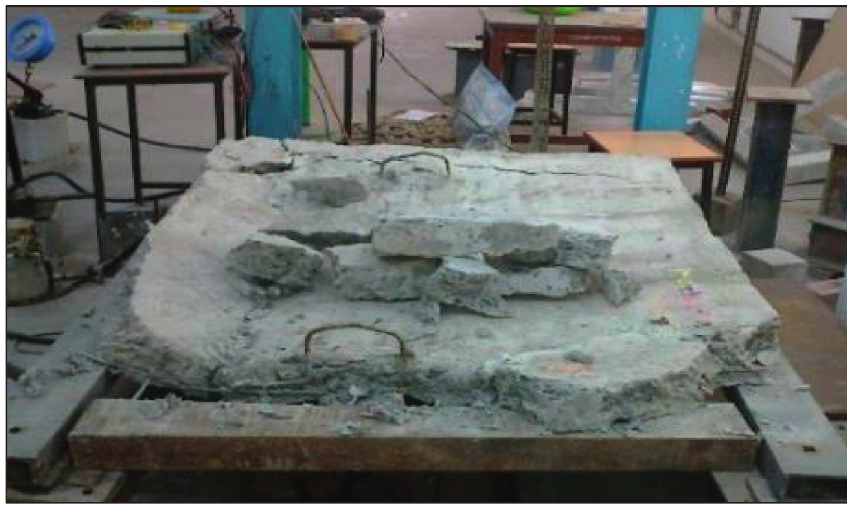
Figure 13: Final brittle collapse of glass fiber reinforced paper mass